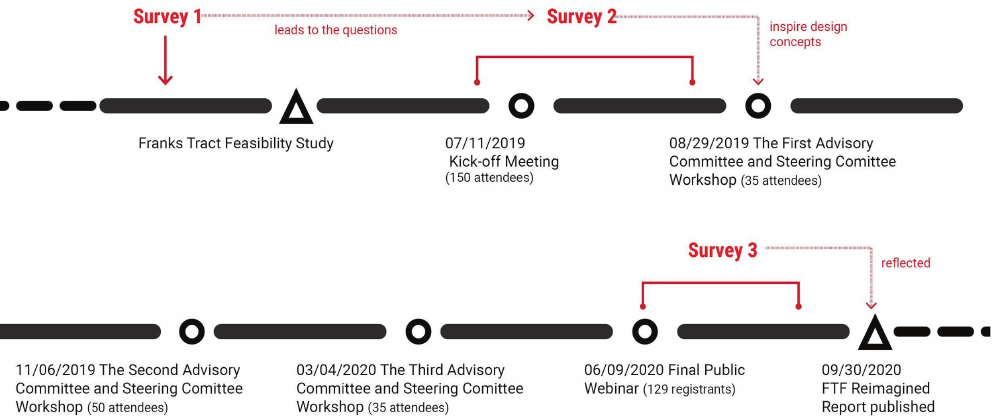
Figure 2. Survey sequence diagram showing the location of the surveys in the overall project